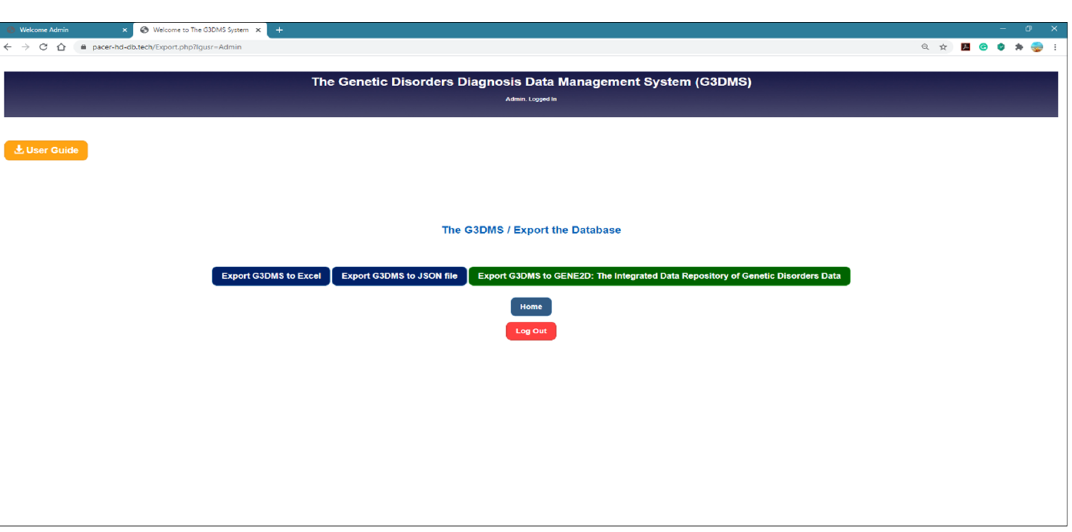
Figure 5. The Export page from the G3DMS to the GENE2D system.